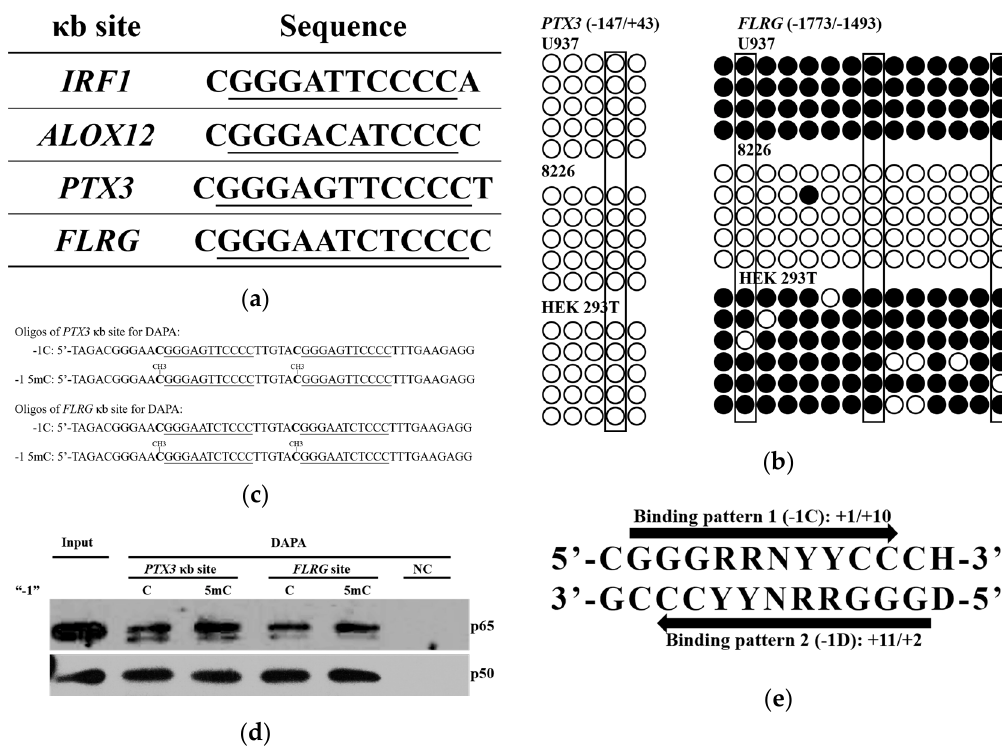
Figure 6. The -1C methylation might not affect NF- κ B binding when there are other binding possibilities. ( a ) Sequences of -1C κ B sites with multiple binding patterns. The κ B site sequences were underlined; ( b ) The methylation status of PTX3 and FLRG κ B sites and their surrounding sequences, analyzed by BSP in U937, 8226 and HEK 293T cells. The CpGs at -1 position of κ B sites are outlined. Methylated and non-methylated CpG sites are shown as solid or empty circles, respectively; ( c ) Sequences of the oligonucleotides with tandem PTX3 or FLRG κ B sites used in DAPA. The κ B site sequences were underlined, the nucleotides at -1 position were in bold; ( d ) Increased binding capacities of p65 and p50 with oligonucleotides bearing 5mC residues at -1C position of κ B sites. DAPA were carried out using oligonucleotides containing κ B sites of PTX3 or FLRG genes shown in Figure 6c and lysates of HEK 293T cells treated with TNF α (10 ng/mL) for 30 minutes. Oligonucleotide-bound NF- κ B was detected by Western blot analysis using antibodies against p65 or p50, respectively. Data shown are the results of one of three experiments. NC, negative control oligonucleotide. Input, 2% of the whole cell lysate used in DAPA; ( e ) Possible κ B sites in PTX3 and FLRG . D = A, T, G; H = T, A, C.